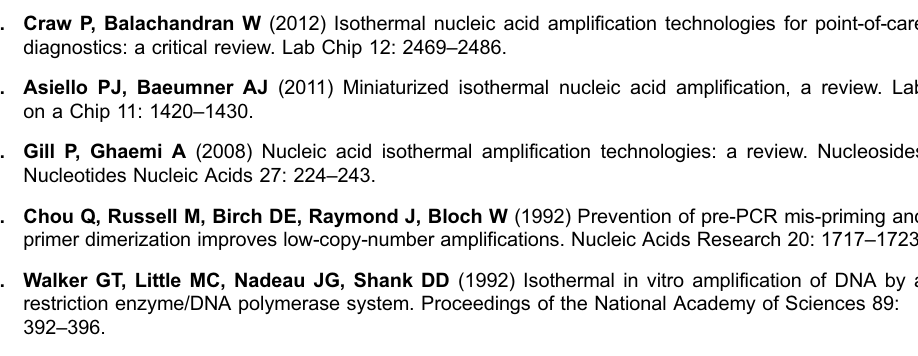
Figure S7. DNA pairing strand exchange assay of a labeled duplex using different IO configurations. (i) IO fully homologous to the target duplex with a 2 9 -O-methyl RNA modification, IO-METH. (ii) IO fully homologous to the target duplex with the 2 9 -O-methyl RNA modification replaced with natural DNA nucleotides, IO-DNA. (iii) IO with a 2 9 -O-methyl RNA modification that is not homologous to the target duplex, IO DIFF-METH. (iv) IO with the 2 9 -O-methyl RNA modification deleted, IO-SHORT. Two duplexes, in which the lengths of the downstream region peripheral to the IO differed (14 bp and 25 bp), were used. Figure S8. Minimal lag time associated with the first round of amplification. The SIBA Salmonella assay was performed in the presence or absence of a restriction enzyme, RsaI either with Salmonella genomic DNA or pre-denatured Salmonella genomic DNA (using DMSO). Amplification was monitored using SYBR Green I. Table S1. Oligonucleotides used in this study. Table S2. Bacterial strains used in this